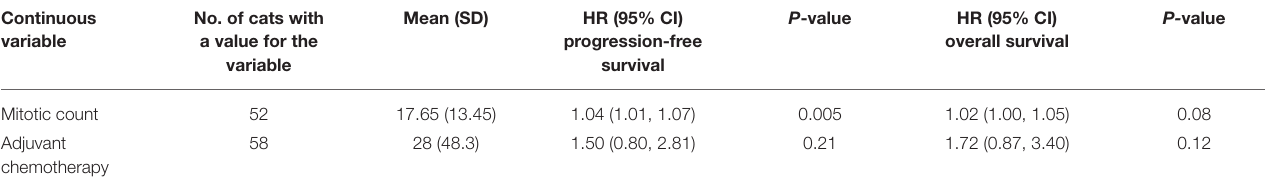
TABLE 2 | Descriptive statistics and results of cox proportional hazards regression for progression-free and overall survival associated with continuous variables. Continuous variable